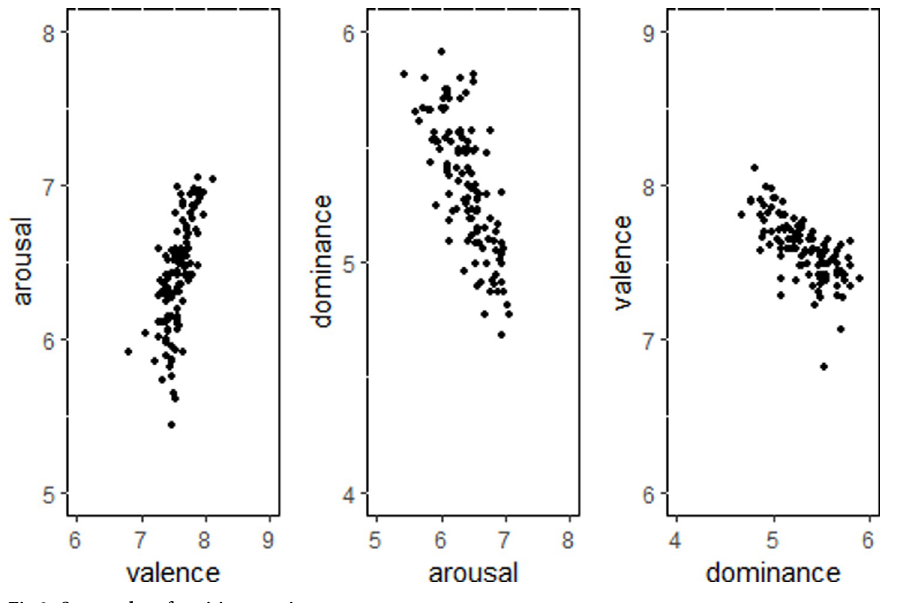
Fig 3. Scatterplot of positive emotions.